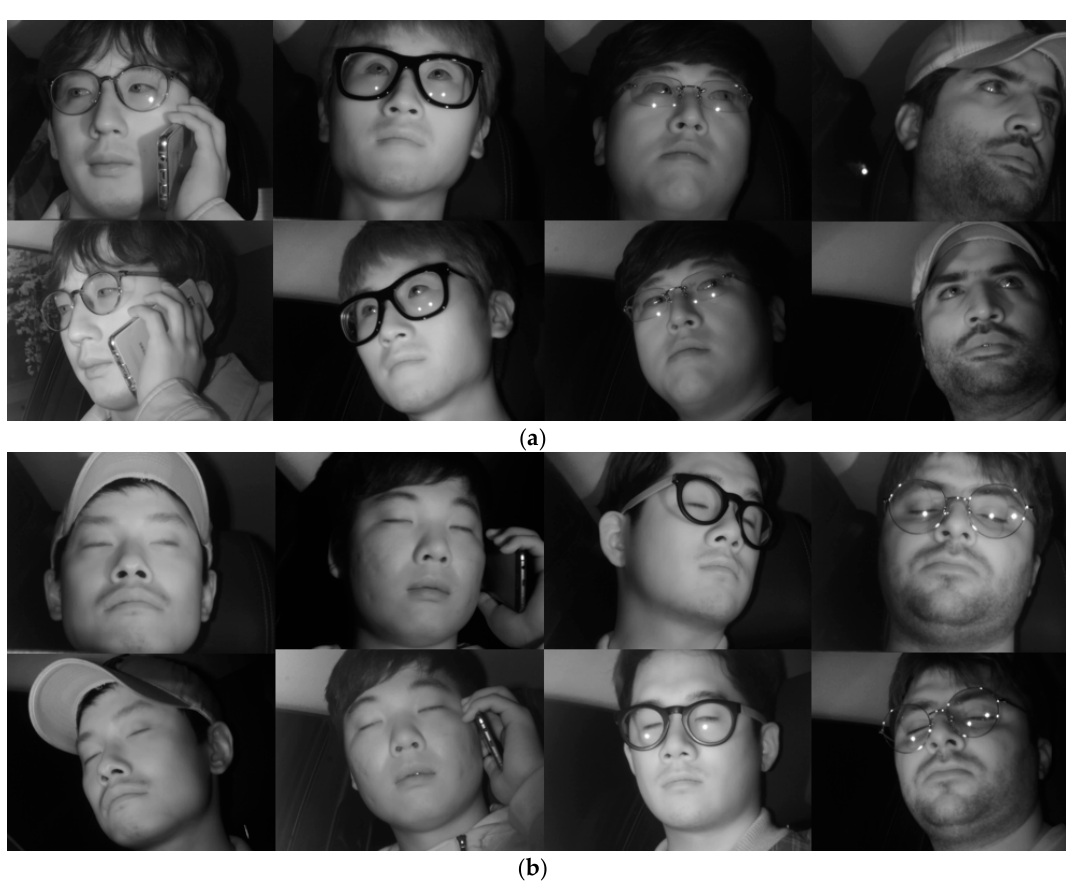
Figure 11. Examples of images in DDCD-DB1. ( a ) Driver’s open eye images captured through the 1st camera (the 1st row images) and 2nd camera (the 2nd row images); ( b ) Driver’s close eye images captured through the 1st camera (the 1st row images) and 2nd camera (the 2nd row images).